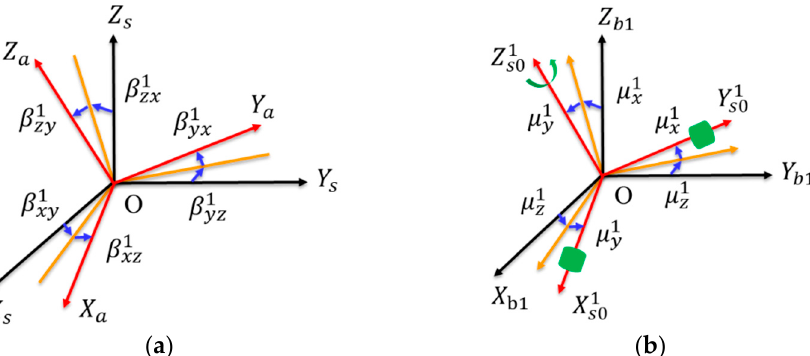
Figure 2. ( a ) Installation errors f rom the a ‐ frame to the s ‐ frame; ( b ) the installation errors of URM 1# from the s0 ‐ frame to the b1 ‐